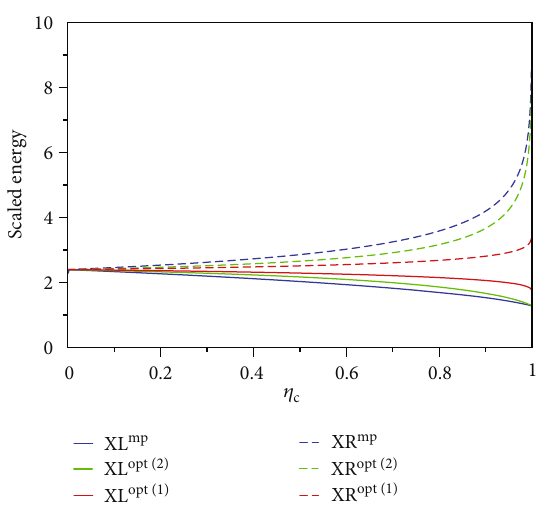
Figure 4: Plot of e ffi ciency at maximum power (blue line); at L at optimized power e ffi ciency when ( η min = η mp ) (red line); at optimized e ffi ciency when ( η min = 0 ) (green); at Carnot e ffi ciency (black) and Curzon Ahlborn e ffi ciency (magenta line) versus η c :